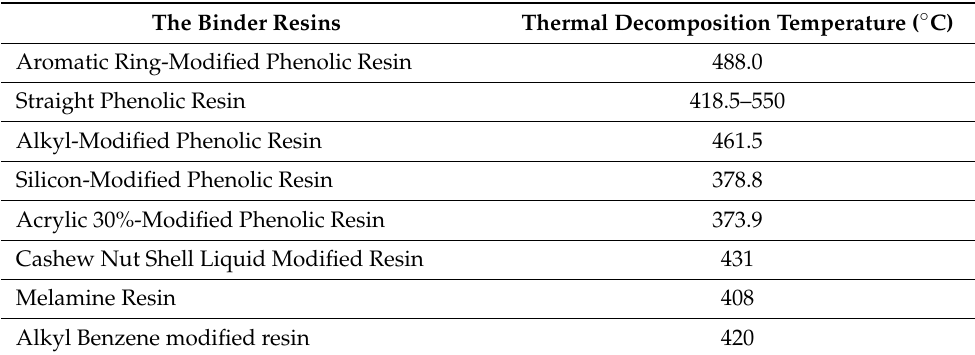
Table 4. The thermal-decomposition temperatures of the binder resins